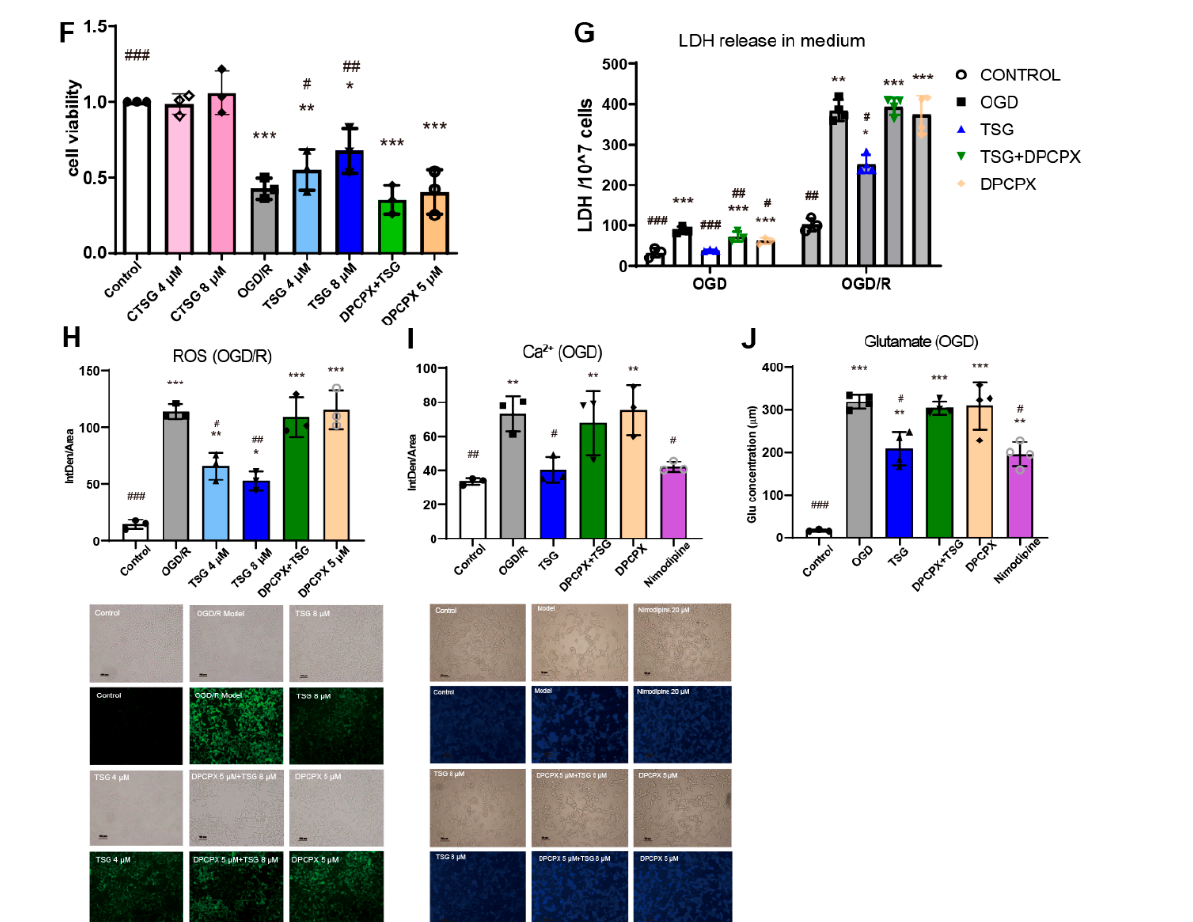
Figure 4. DPCPX abolished the neuroprotection of TSG in vivo and in vitro. ( A ) TTC staining of cerebral slices and cerebral infarct volume percentage (% of hemisphere), n ≥ 8. ( B ) Neurobehavioral scores and mortality of rats ( n ≥ 7). ( C ) Boxplots of biological parameters SOD, MDA ( n = 4). ( D ) Bar plots for the positive expression ratio of NeuN ( n = 3). ( E ) HE staining, NeuN and GFAP immunostainings of brain sections from the model, TH, DPCPX + TH and sham groups, n = 3. Scale bar represents 50 µ m. ( F ) Cell viability of SH-SY5Y cells with different treatment (CTSG: Control + TSG; DPCPX + TSG: 5 µ M, 8 µ M, respectively) after OGD/R and under normoxic condition was determined by the CCK-8 assay. ( G ) Cellular LDH release were determined after OGD 3 h and OGD/R with treatment of TSG (8 µ M), DPCPX (5 µ M), DPCPX (5 µ M) + TSG (8 µ M) combination. ( H ) Intracellular ROS in OGD/R cells was reflected by the fluorescence intensity with DCFH-DA probe (intracellular ROS assay) stained. Representative immunofluorescence images of SH-SY5Y cells are shown. Scale bar represents 100 µ m. ( I ) Ca 2+ influx was determined by immunofluorescence staining assay after OGD. Representative immunofluorescence images of SH-SY5Y cells are shown. Scale bar represents 50 µ m. ( J ) Glutamate release in medium was determined by glutamate assay kit after OGD. The mean fluorescence intensity was calculated by Image J software. # p < 0.05, ## p < 0.01 and ### p < 0.001, other groups vs. model/OGD/R group; * p < 0.05, ** p < 0.01 and *** p < 0.001, other groups vs. sham/control